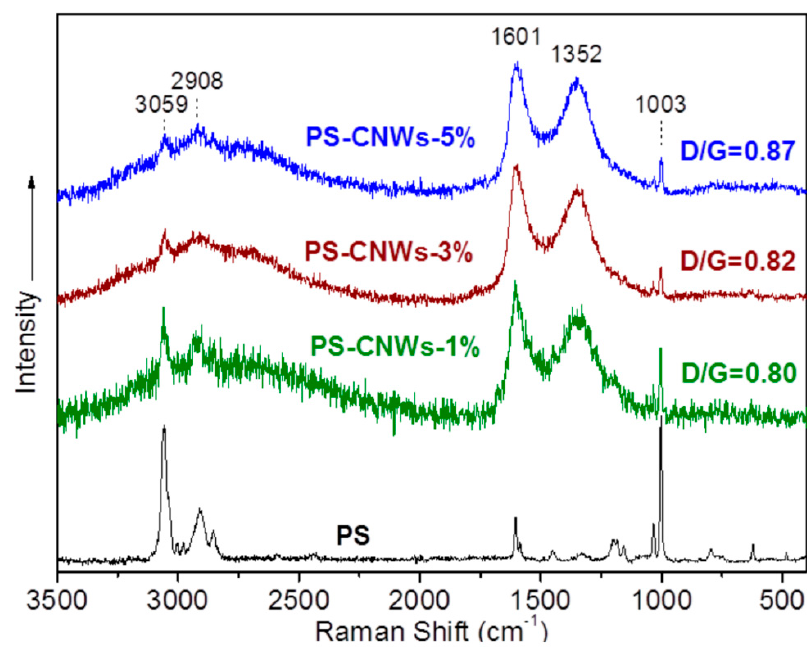
Figure 7. Raman spectra of neat PS, PS-CNWs-1%, PS-CNWs-3% and PS-CNWs-5% samples.